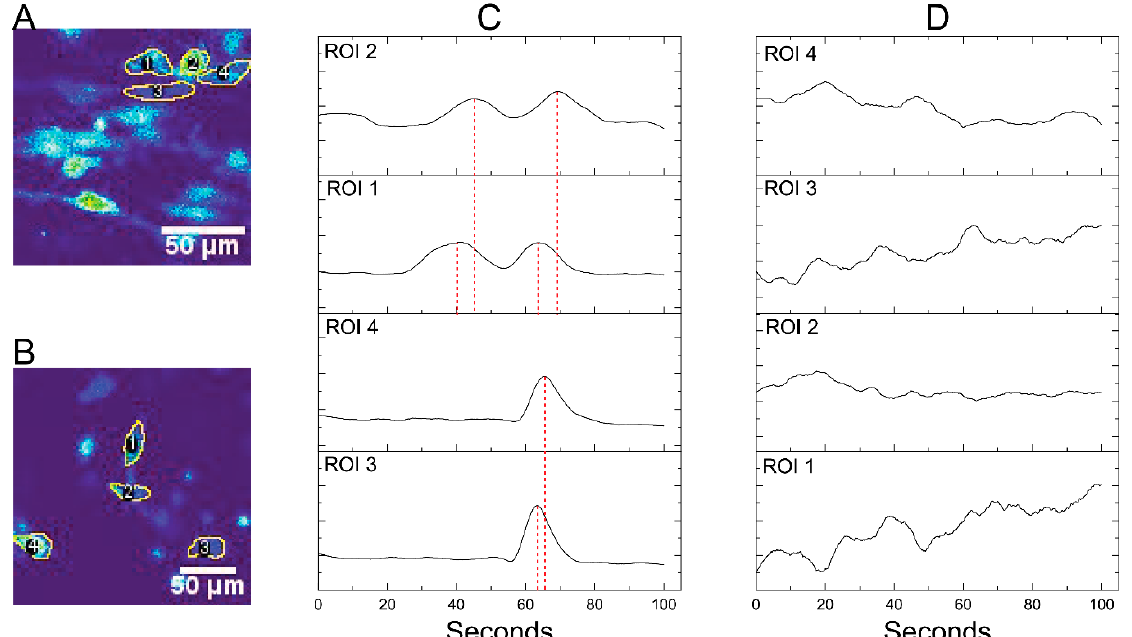
Figure 5. Spontaneous activity of the differentiated SH-SY5Y cells within the hydrogel scaffolds. Time-lapse image sequences ( A ) and ( B ) of measured calcium signals in a neuronal cell inside the composite hydrogels corresponding to supplementary movie S1 (aligned) and movie S2 (random), respectively. Normalized calcium transients of aligned ( C ) and randomly oriented cells ( D ).